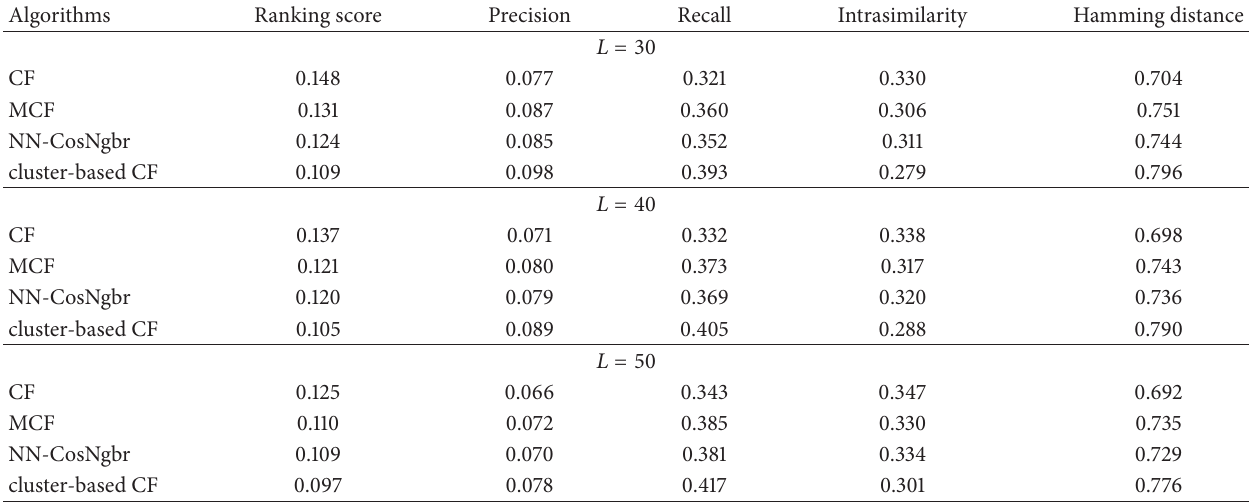
Table 2: Algorithmic performance for MovieLens dataset. The ranking score, precision, recall, intrasimilarity, Hamming distance are corresponding to 𝐿 = 30, 40, and 50. Each number presented in this table is obtained by averaging over five runs, each of which has an independently random division of training set and test.